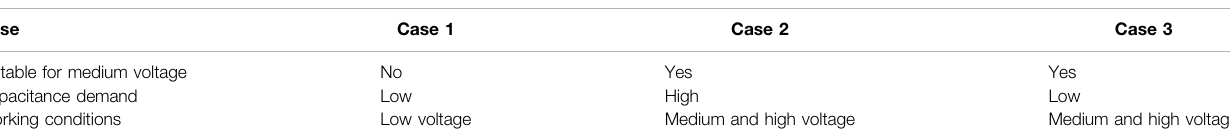
TABLE 3 | Comparison of different